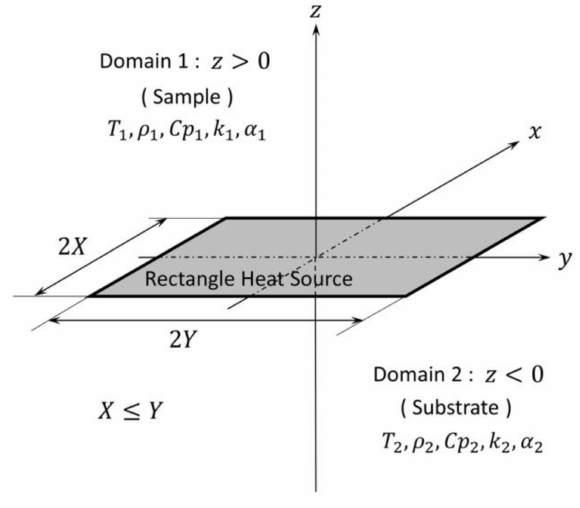
Figure 2. Model for the rectangle heat source on the interface of two semi-infinite